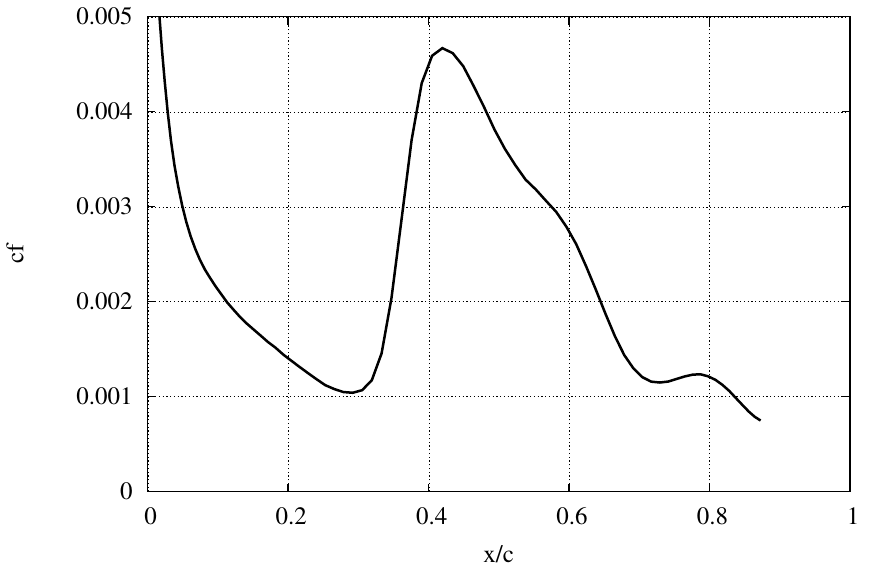
Figure 8. Location of transition from wall shear stress ( c f ) by CFD code FLOWer. N = 5 corresponds to a TI ( TI ) of 0.3%. Onset of transition may be located at x / c = 0.29, and flow is fully turbulent at x / c = 0.42. Slope is at maximum at x / c =